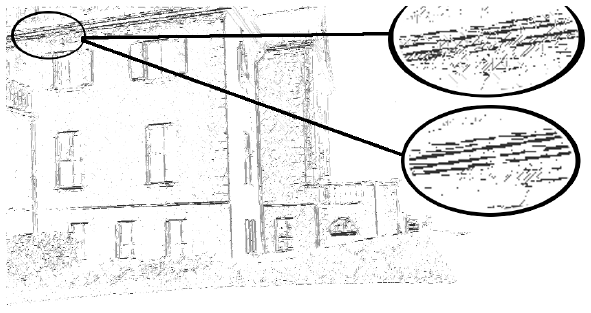
Figure 5: Result before (top) and after histogram filtering (be- low) for the point cloud from the principalship. The different directions of edge points are drawn in different grey